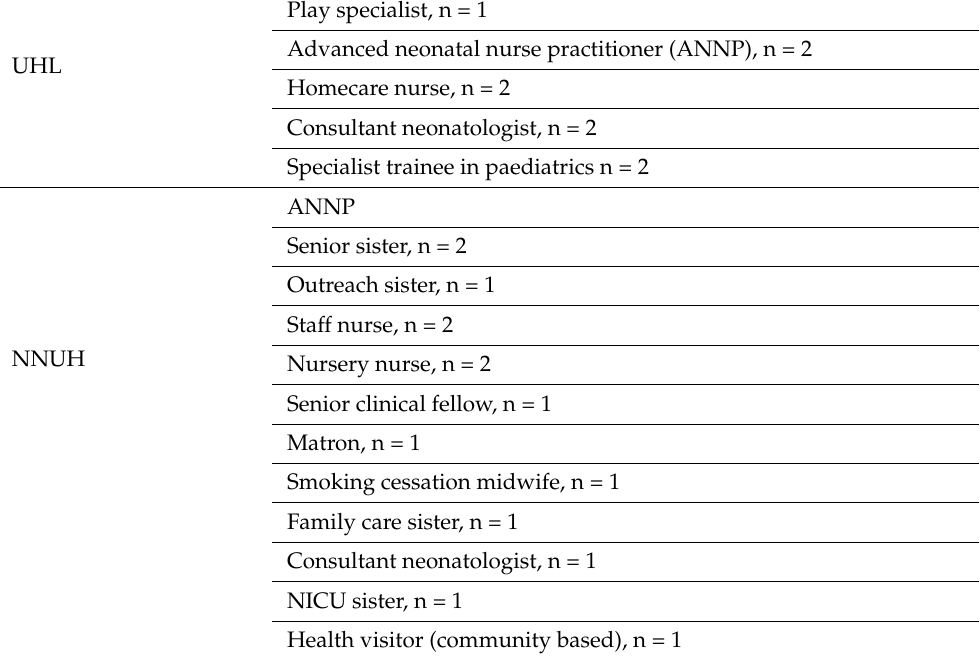
Table 2. Overview of HCPs